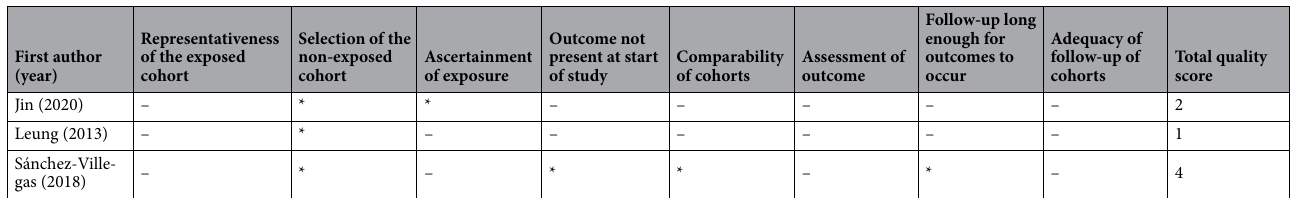
Table 4. Quality assessment of the included cohort studies according to the Newcastle–Ottawa Scale.